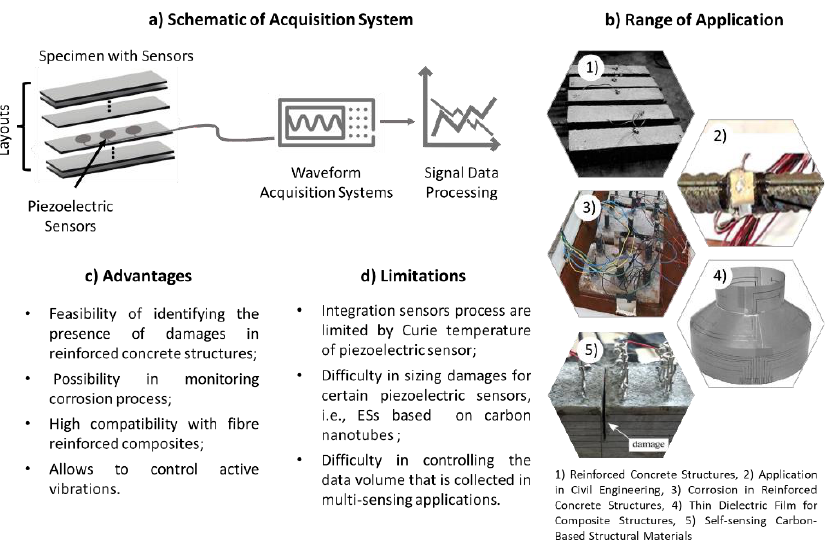
Figure 6. Piezoelectric sensors embedded into composite components.